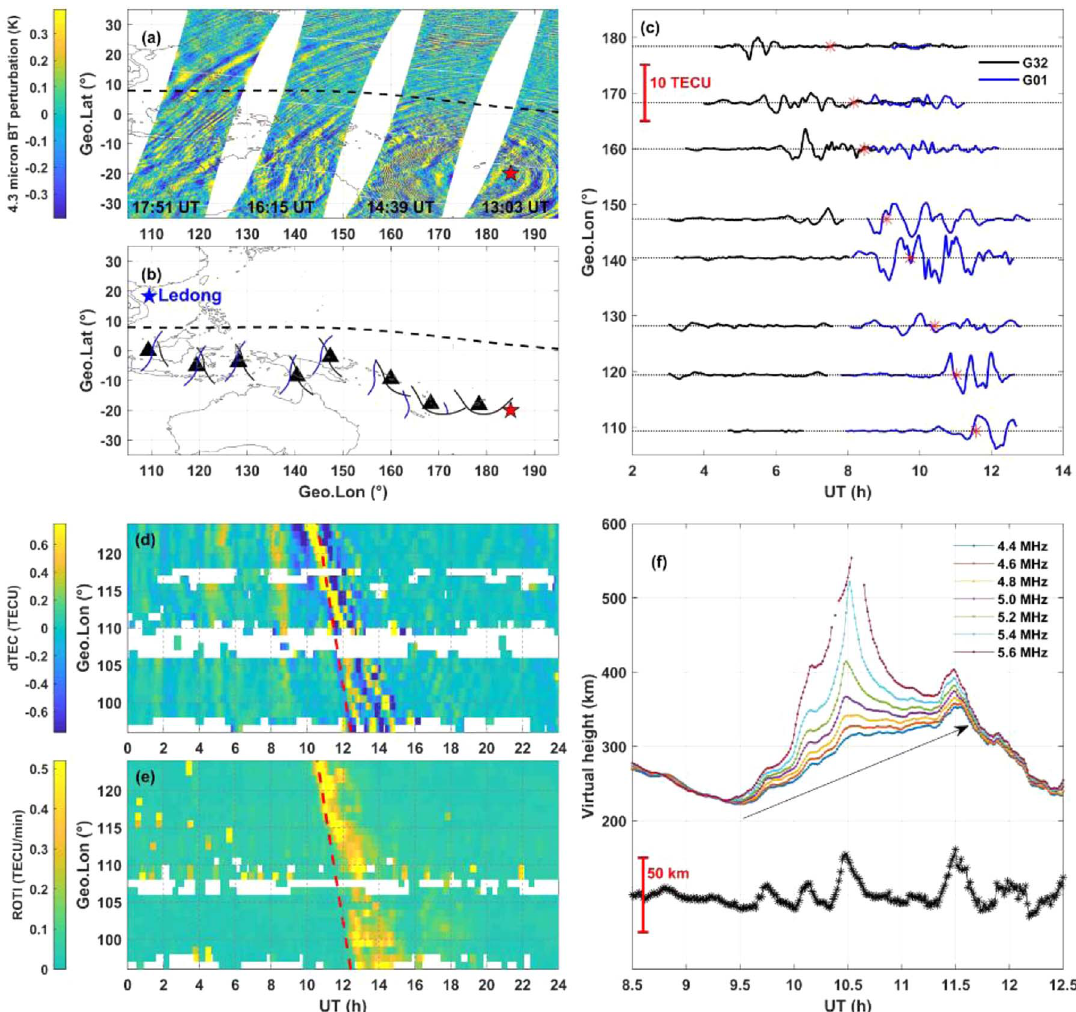
Fig. 5. (a) AIRS observation of concentric stratospheric gravity waves in 4.3 l m radiance. (b) The geographic locations of GNSS sites (triangles) and IPP trajectories (black and blue solid curves) connecting Tonga to the magnetic dip equator conjugate to the East/Southeast Asia. (c) The dTEC obtained from the GPS satellites G01 and G32 for the GNSS sites in (b). (d) The dTEC and (e) ROTI at the Asian longitudes along the magnetic dip equator averaged using all the data at 0 – 15 (cid:3) N. (f) The plasma virtual heights at several selected frequencies derived from the Ledong ionosonde and the 60-min fi ltered virtual height at the plasma frequency 5.0 MHz (black asterisk curve). The red stars and black dashed curves in (a) – (b) mark the location of the Tonga volcano and the magnetic dip equator, respectively. The blue star in (b) marks the location of Ledong. The red asterisks in (c) indicate the E-region sunset at the location of each site. The red dashed curves in (d) – (e) denote the E-region sunset terminator. The black arrow in (f) indicates the elevation of the F layer